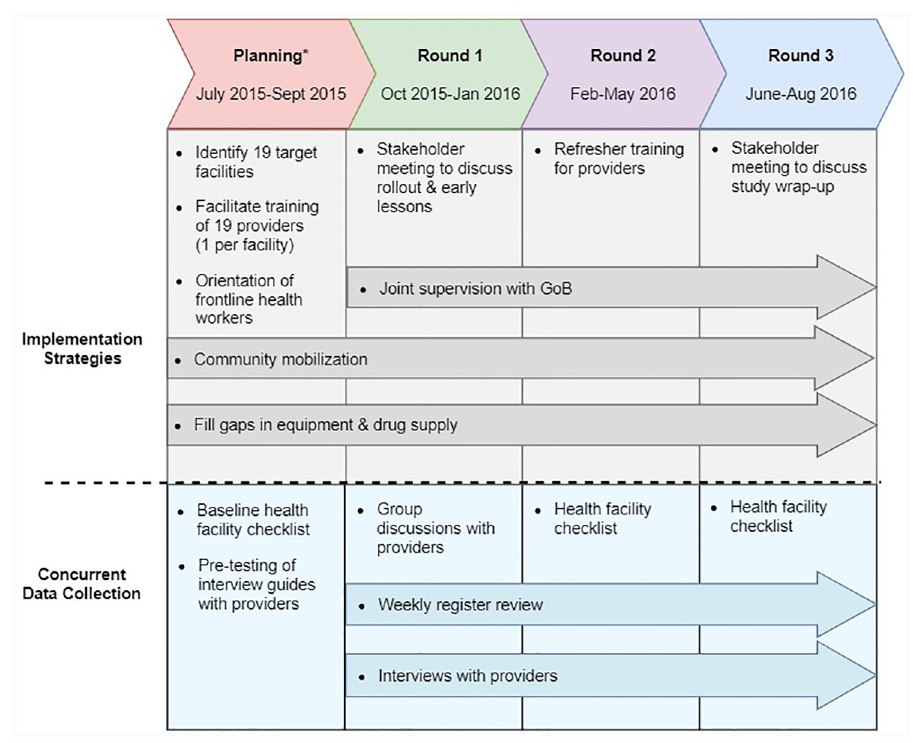
Fig 1. Study timeline: Implementation strategies & concurrent data collection. � Infection management guidelines rolled out in selected districts in August